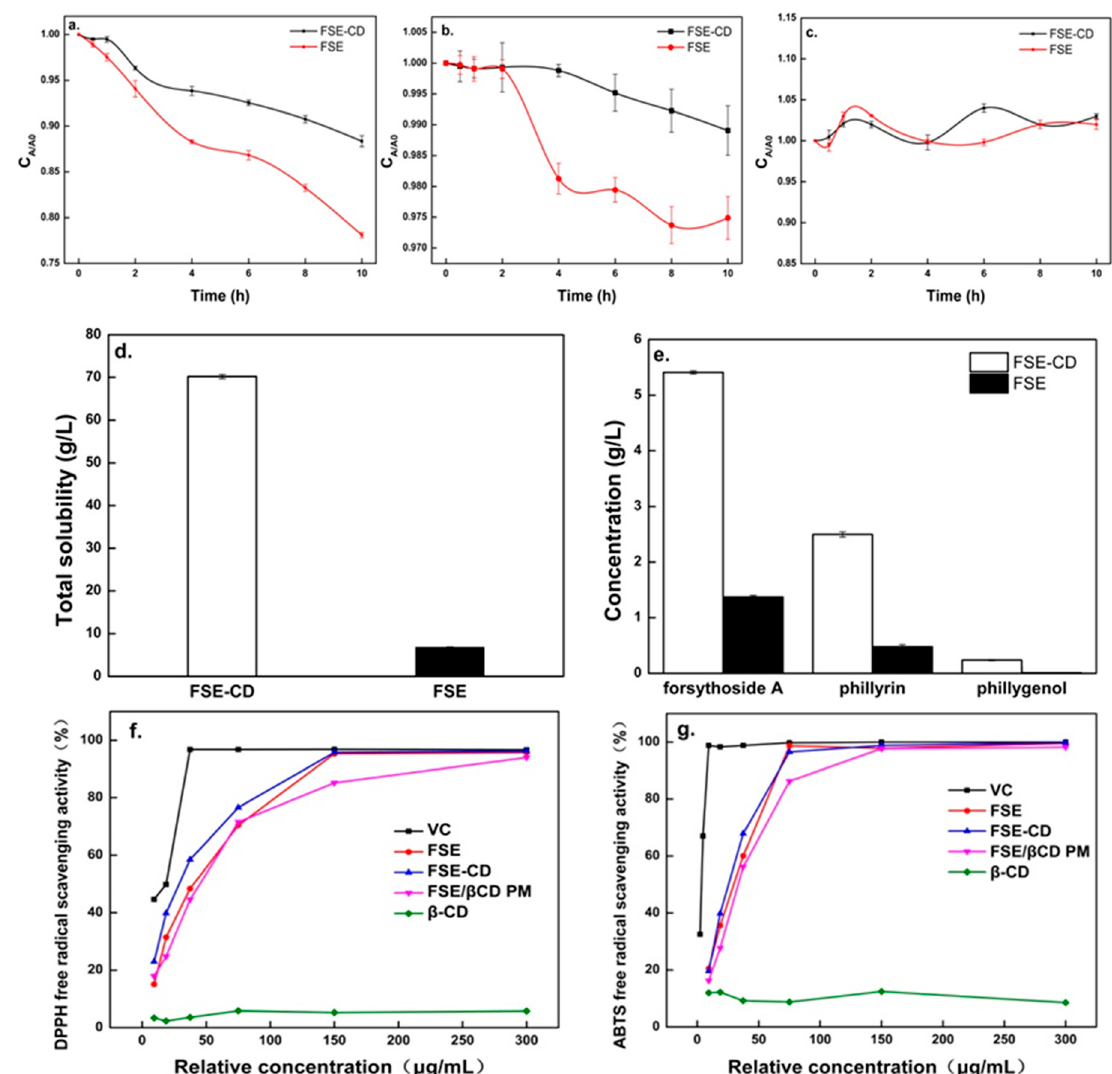
Figure 8. Thermal stability study of extraction of Forsythia suspensa leaves, aqueous solubility experiments of FSE- β -CD and FSE and in vitro antioxidant activities of samples. Stability of forsythoside A ( a ), phillyrin ( b ) and phillygenol (c), total solubility of FSE- β -CD and FSE ( d ), solubility of natural active substances ( e ), DPPH radical scavenging activity (f) and ABTS radical scavenging activity ( g ).